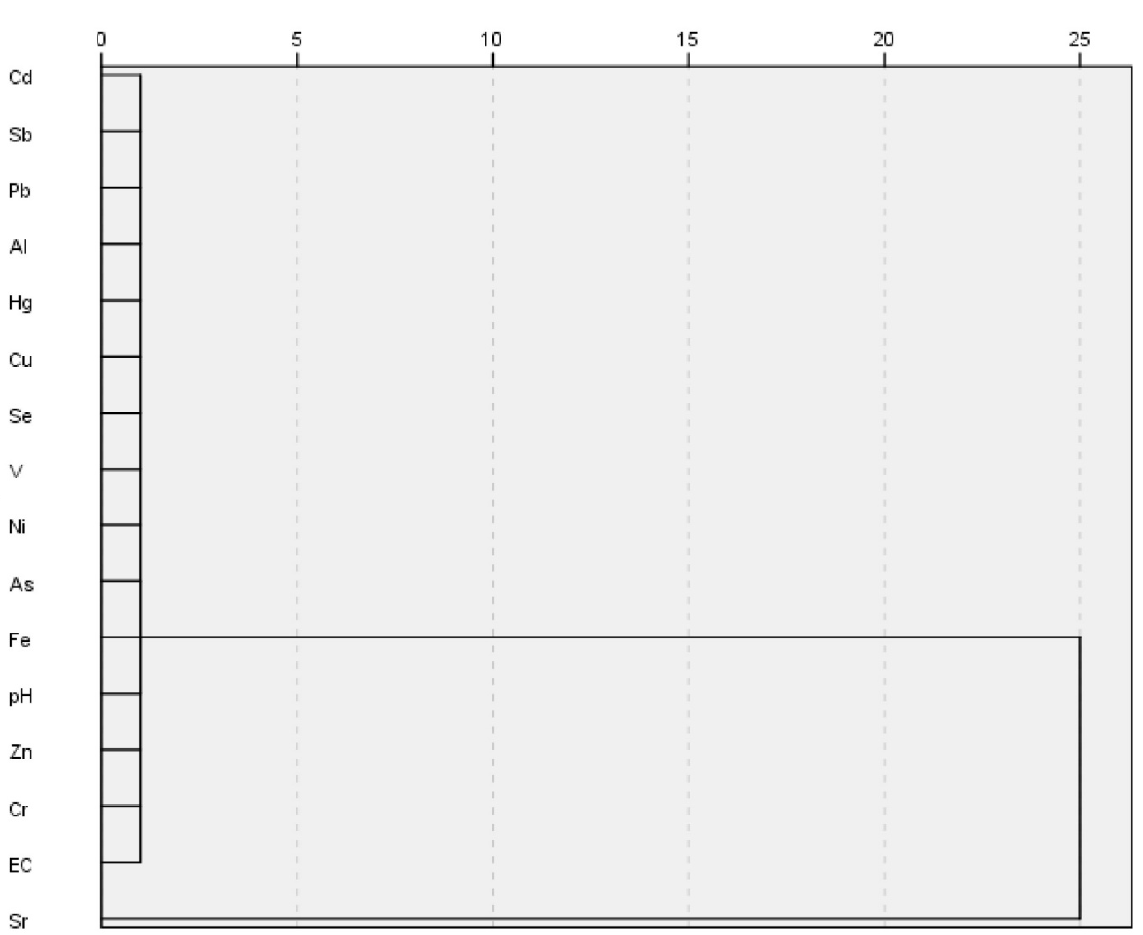
Figure 6. Distribution of water pollution index (PIj), degree of contamination (Cd), and heavy-metal pollution index (HPI) of Al-Ugair surface seawater samples. Table 4. Correlation matrix of the investigated HMs.